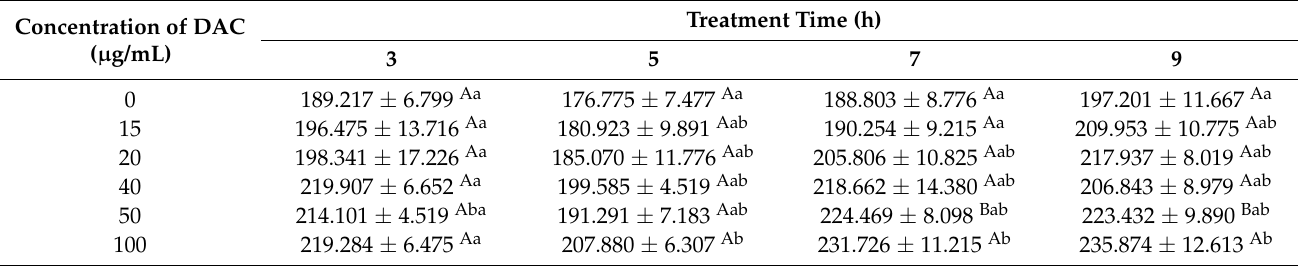
Table 9. The effect of DAC on LDH activity in GMEC (U/L).